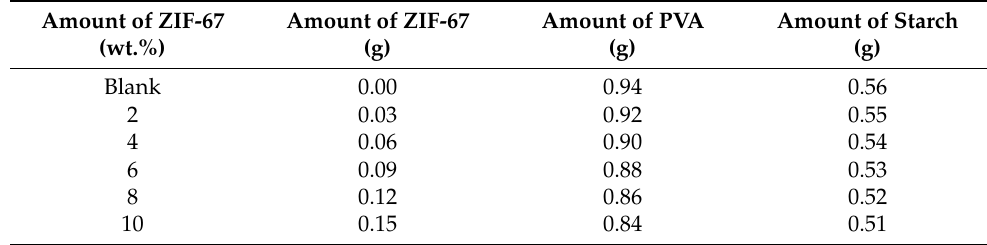
Table 1. The concentration of ZIF-67 in PVA–Starch films with a corresponding amount of additive. Amount of ZIF-67 Amount of ZIF-67 Amount of PVA (wt.%) (g)